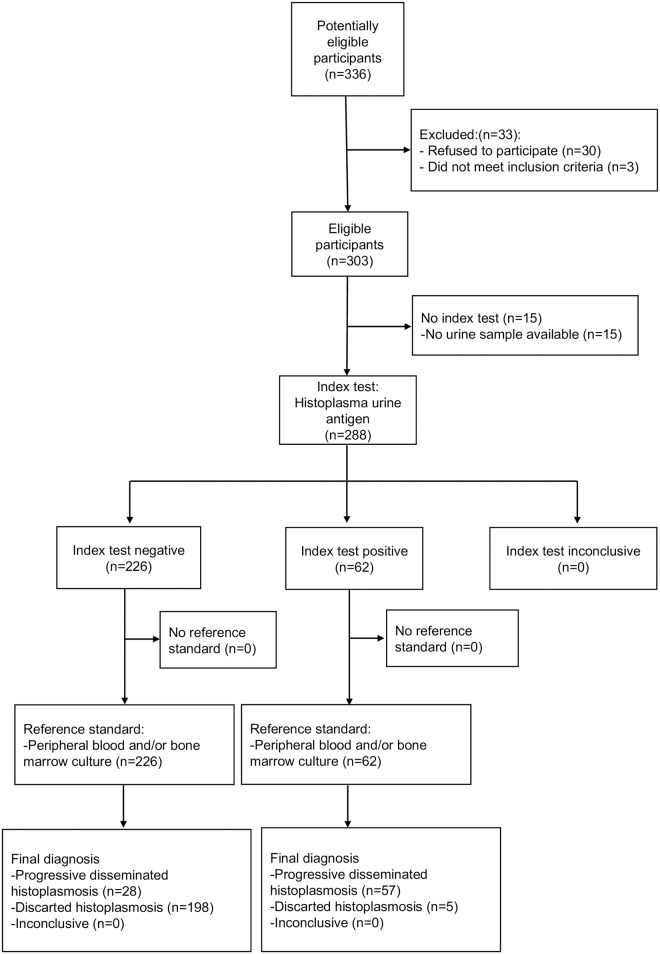
Study flowchart.